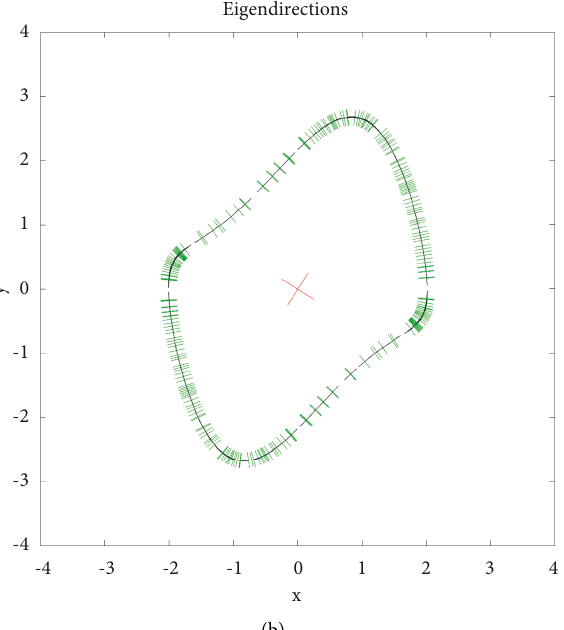
Figure 9: System (20): (a) Eigenvalues of the Hessian at points of the chain recurrent set: green (positive, attractive), black (zero, neutral), and red (negative, repelling). (b) Corresponding eigendirections, indicating attractive, repelling, and neutral directions to the connected component of the chain recurrent set. The periodic orbit has a 1-dimensional neutral direction and a 1-dimensional attractive one, while the equilibrium has a 2-dimensional unstable manifold.